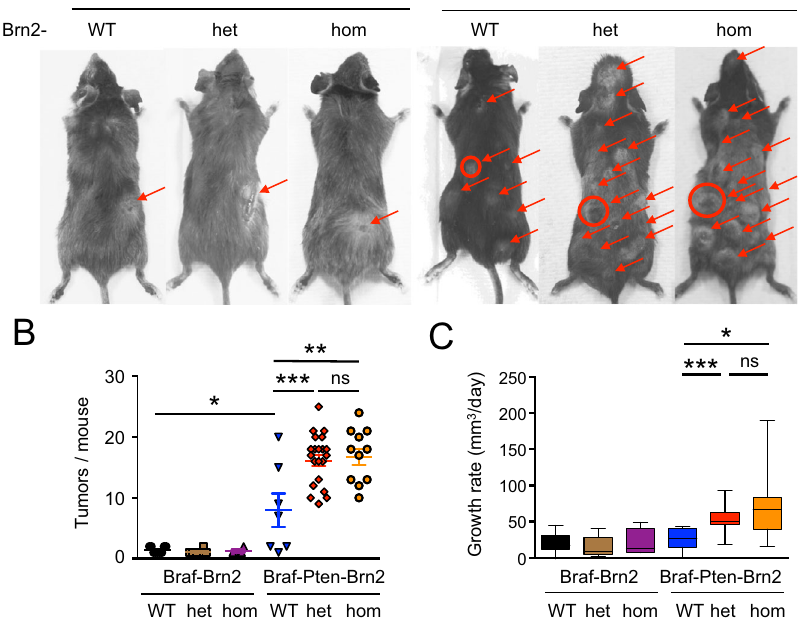
Fig. 2 Brn2 loss potentiates melanomagenesis in Braf-Pten mice. A Macroscopic pictures of the dorsal view of mice with cutaneous melanomas carrying mutations in the melanocyte lineage for Braf, Pten, and Brn2 after tamoxifen induction at birth (p1, p2, and p3 – see Supplementary Fig. 3). Tyr::CreER T2/° ; Braf V600E/ + ; Pten + / + ( = Braf), Pten F/ + ( = Pten), Brn2 + / + ( = Brn2-WT), Brn2 F/ + ( = Brn2-het), and Brn2 F/F ( = Brn2-hom). Tumors are highlighted with arrows and the sizes of the fi rst growing tumors to appear are proportional to the diameters of the circles. F means fl oxed allele. B All Braf ( n = 9), Braf- Brn2-het ( n = 8), and Braf-Brn2-hom ( n = 4) mice produced cutaneous melanomas and their number was similar (1 to 2 tumors/mouse). All Braf-Pten- Brn2-WT ( n = 7), Braf-Pten-Brn2-het ( n = 21), and Braf-Pten-Brn2-hom ( n = 11) mice produced cutaneous melanomas. Note that in the absence of Pten ( Pten F/F ), the appearance of the melanoma was too rapid to observe any difference between Brn2-WT, Brn2-het, and Brn2-hom mice. Each dot corresponds to an individual mouse. As control, mice of different genetic backgrounds were produced and not induced with tamoxifen Braf [ n = 12], Braf- Brn2-het [ n = 25], Braf-Brn2-hom [ n = 11], Braf-Pten [ n = 7], Braf-Pten-Brn2-het [ n = 13], and Braf-Pten-Brn2-hom [ n = 6]; none of them developed melanoma after 18 months, except one Braf-Pten-Brn2-het mouse that developed one melanoma after 12 months. None of the mice that were wild-type for Braf displayed any obvious phenotype, irrespective of the status of Pten or Brn2 , including melanomagenesis and hyperpigmentation. C Growth rates of the fi rst tumor appearing in each mouse for Braf-Brn2-WT, Braf-Brn2-het, Braf-Brn2-hom, Braf-Pten-Brn2-WT, Braf-Pten-Brn2-het, and Braf-Pten-het-Brn2- hom mice. The number of tumors is determined all along the life of the mouse by checking the mice a minimum of twice a week. Statistical analysis was performed using the two-tailed unpaired t test. ns = non-signi fi cant, * p < 0.05, ** p < 0.01, and *** p < 0.001. Data are presented as mean values ± SEM. Braf- Pten-Brn2-het mice were euthanized in average 1.3 weeks after appearance of the fi rst tumors with an average of 16 tumors/mouse. Similar results were obtained with Braf-Pten-Brn2-hom mice. Braf-Pten-Brn2-WT mice were euthanized at 4 weeks with an average of 8 tumors even though they did not reach a total volume of 2 cm 3 except for one mouse that was euthanized earlier (3